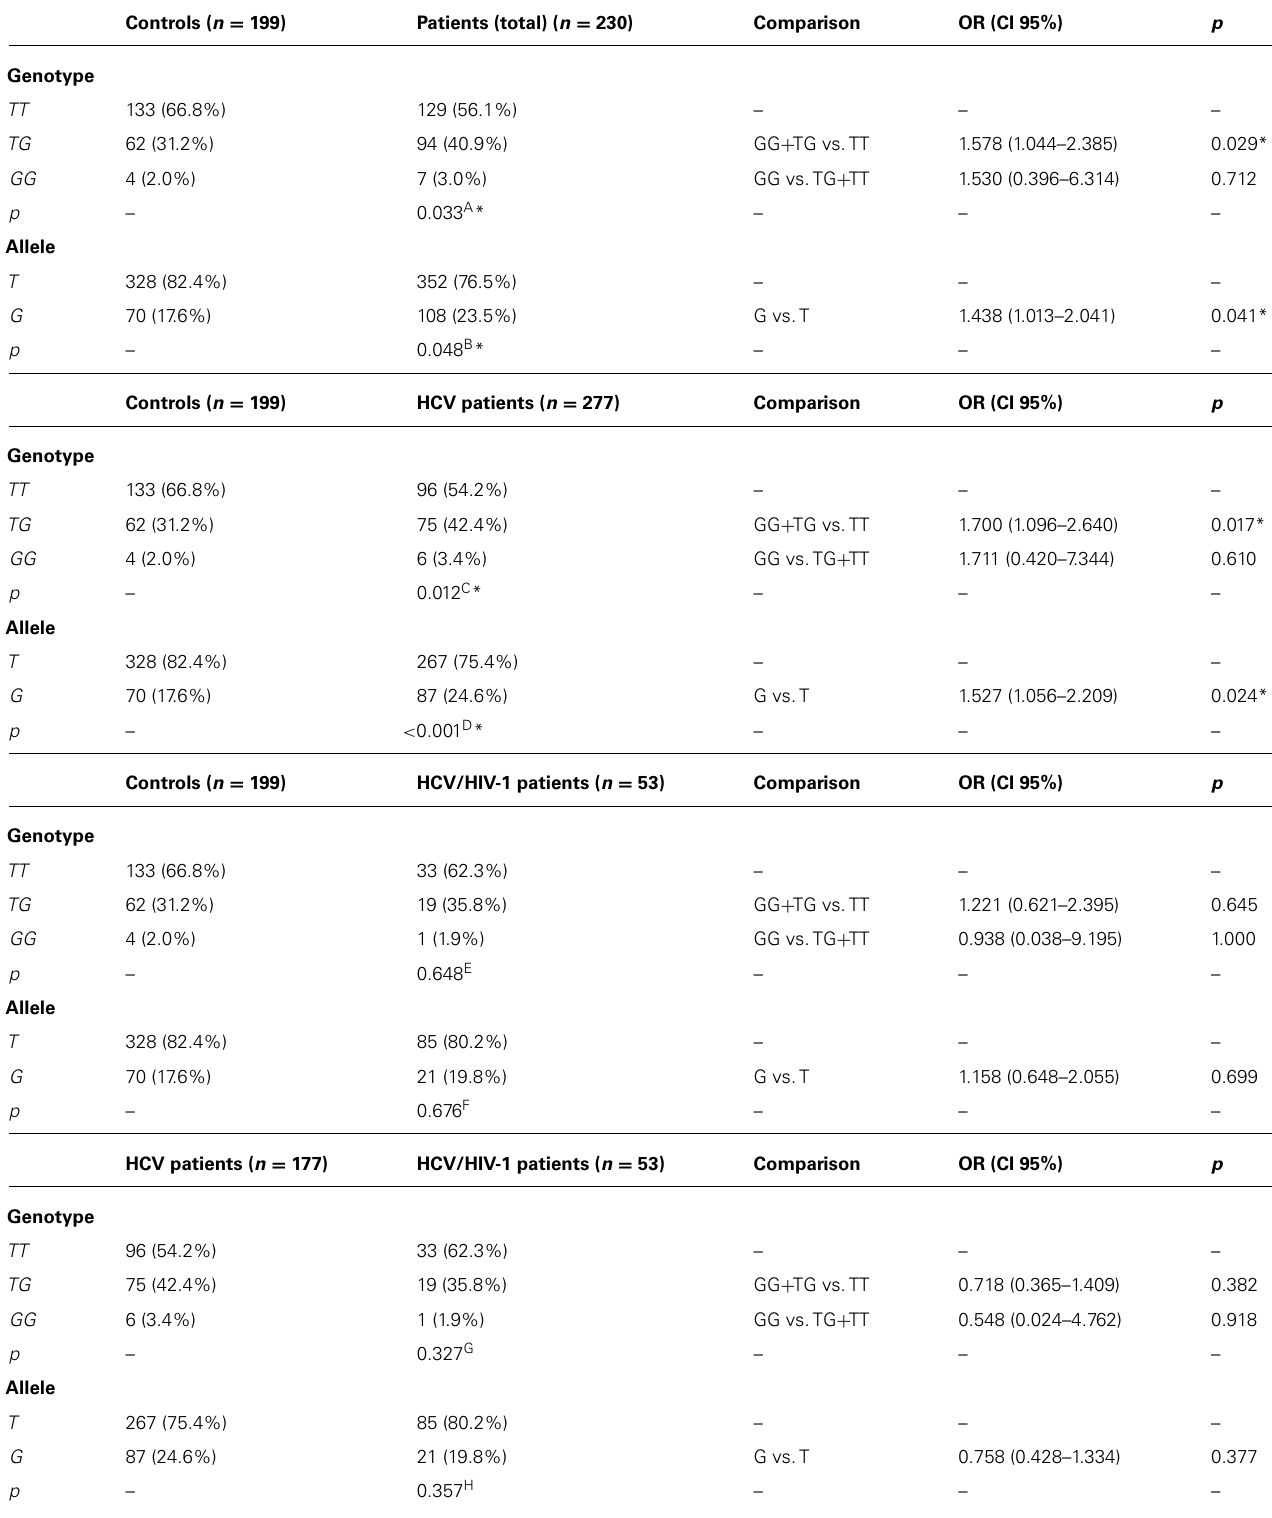
Table 3 |Allelic and genotypic frequencies and association analysis –